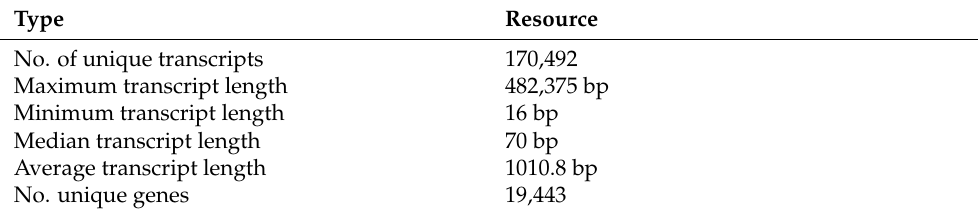
Table 1. Summary of the RNA-sequence dataset of the Caco-2 cell line.